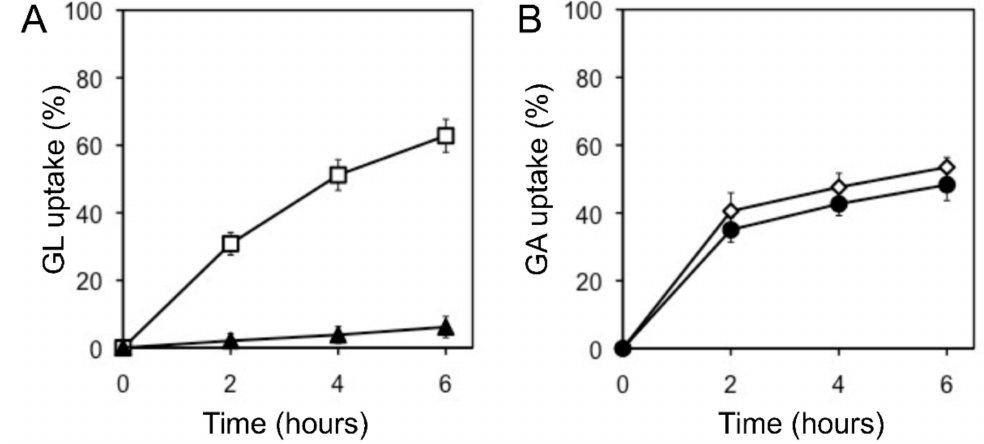
Figure 4. Effect of GA on GL uptake by cultured cells of G. glabra . ( A ) GL uptake was measured with (filled triangles) or without (open squares) GA. ( B ) GA uptake was measured with (filled circles) or without (open diamonds) GL. The final concentration of each compound was 100 µ M. The value of 100% indicates the amounts of GL or GA added to the medium at 0 h. Data are presented as the mean ± standard deviation from triplicate